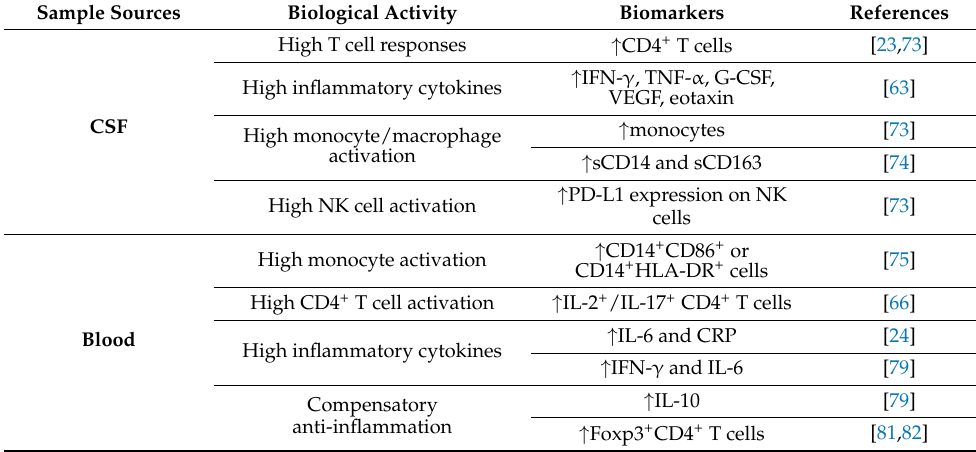
Table 2. Biomarkers at the time of cryptococcal IRIS